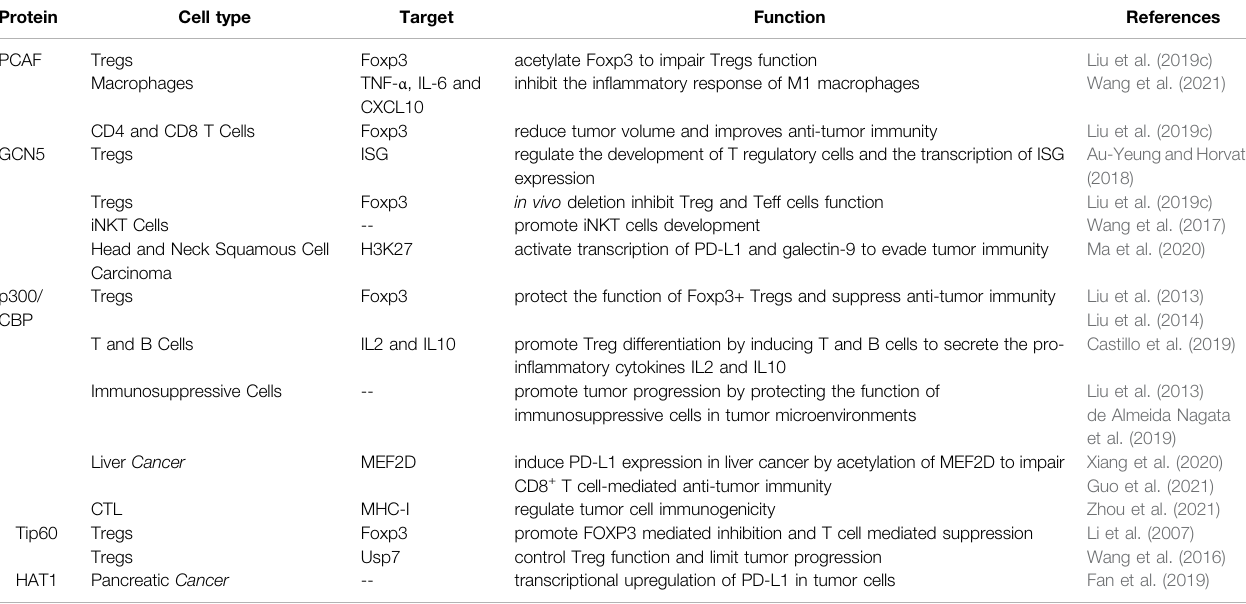
TABLE1 | Function of HATs related to tumor immunity in different cell types.